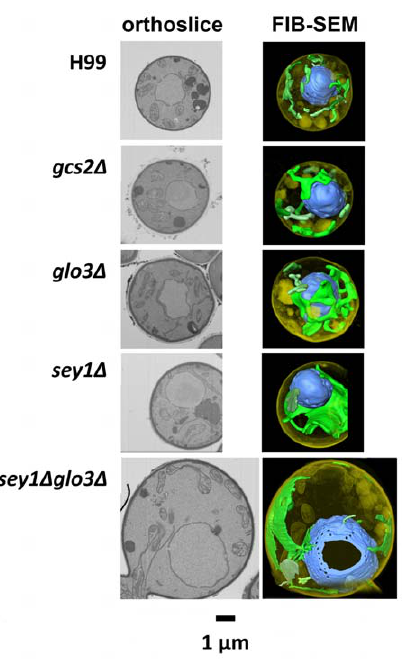
Figure 8. The FIB-SEM showed all mutants to have variable degrees of aberration in ER morphology. Left column shows orthoslices representing central slices through the volume. 3D reconstructions of the ER in indicated strains were generated from data collected by serial 3–10 nm cuts of each sample through the cell. ER and nuclei were psuedo-colored with green and blue color, respectively. The FIB-SEM picture of H99 was taken at different angle from the orthoslice to have a clearer view of the ER